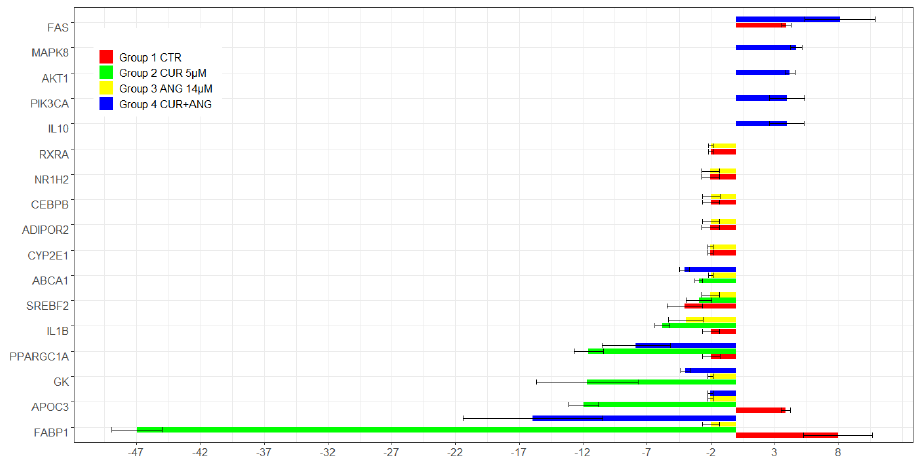
Figure 5. Relative changes in the fold expression of the genes involved in human fatty liver pathways (genes selected with p -value cutoff of 0.05). The analysis was performed in genes differentially expressed with respect to the steatosis control in dependence of the treatment with curcumin (group 2, green), andrographolide (group 3, yellow), and curcumin + andrographolide (group 4, blue). Group 1 (red) represents the HepG2 control grown in